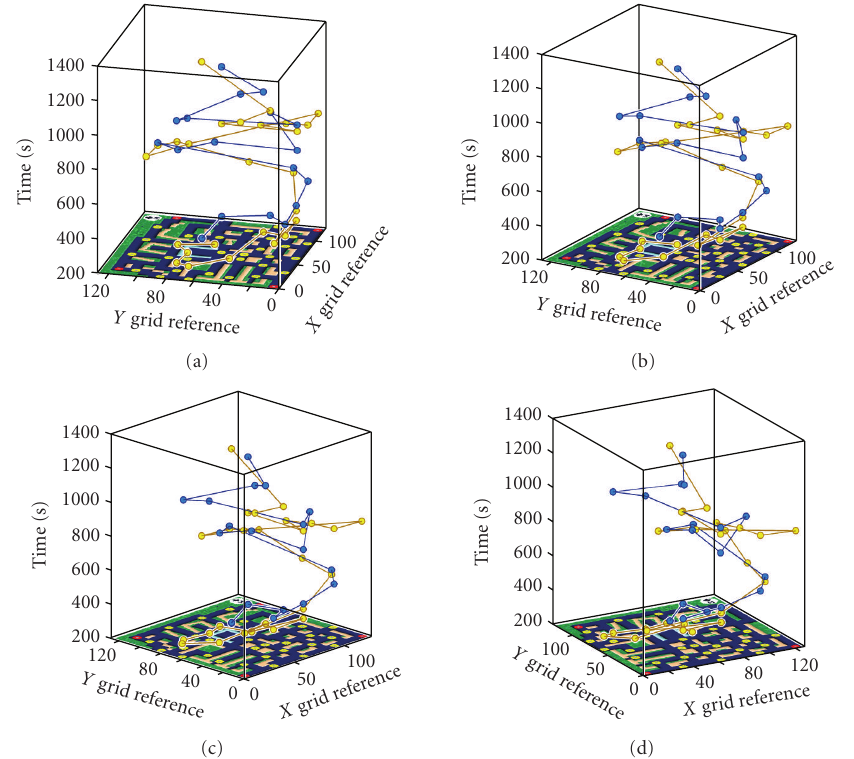
Figure 4: Rotating space-time paths for PAC-LAN and Mr. Blue.